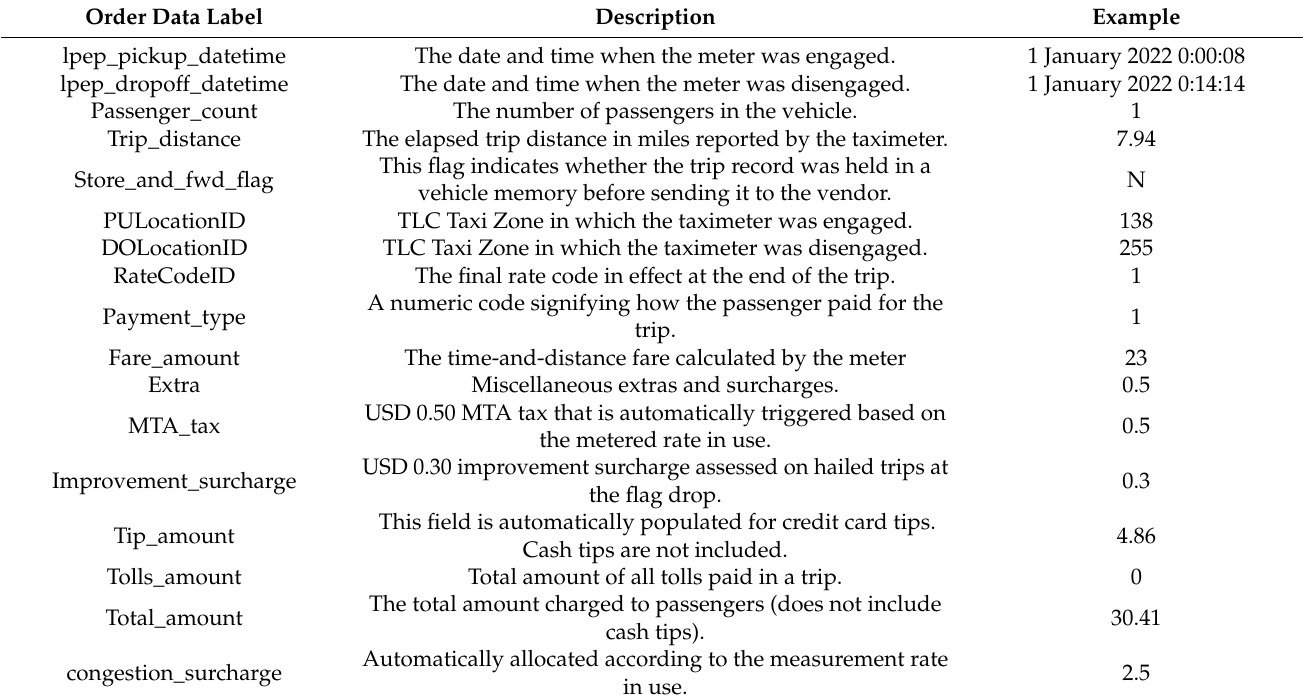
Table 1. Table 1. Order Data and Track Data